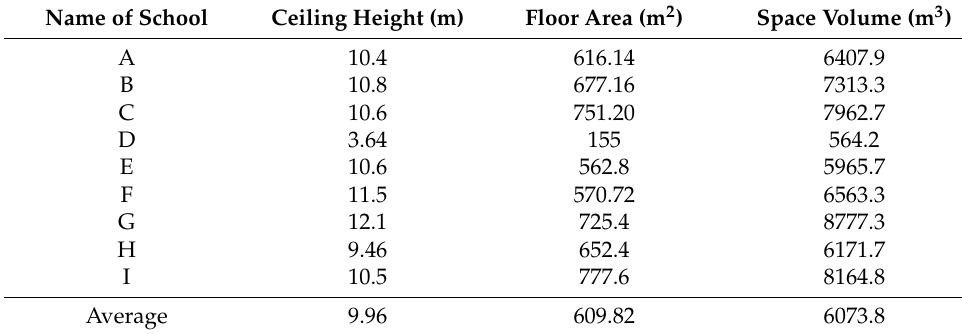
Table 1. Height, area, and volume of the MPA-space of the nine elementary schools.